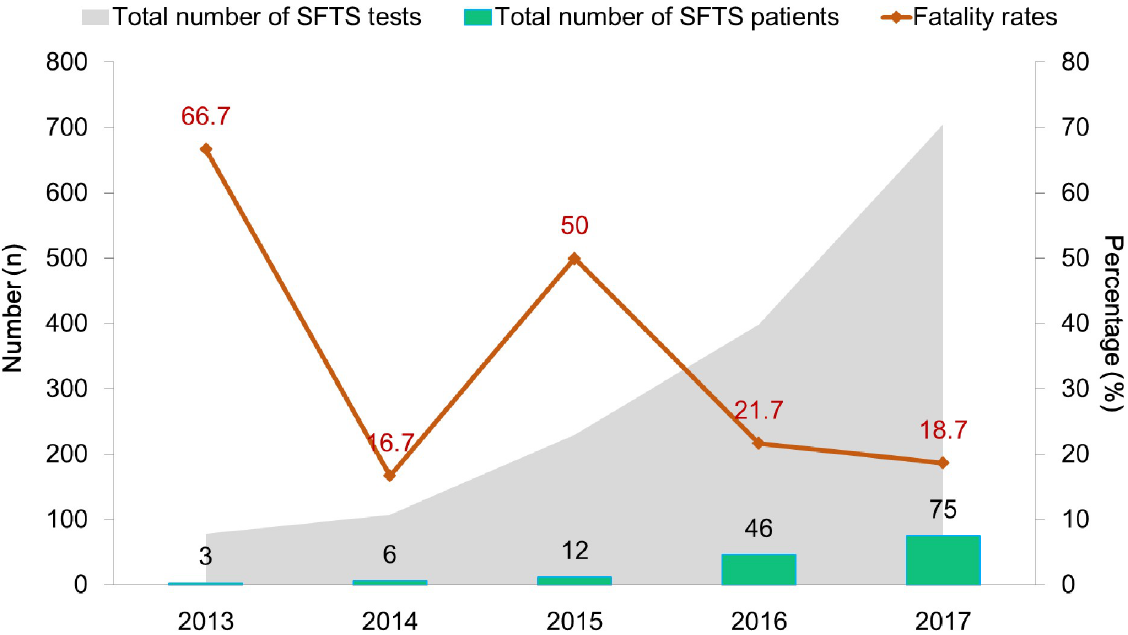
Fig 1. Number of patients enrolled in multicenter cohorts with confirmed severe fever with thrombocytopenia syndrome (SFTS) and mortality between 2013 and 2017.